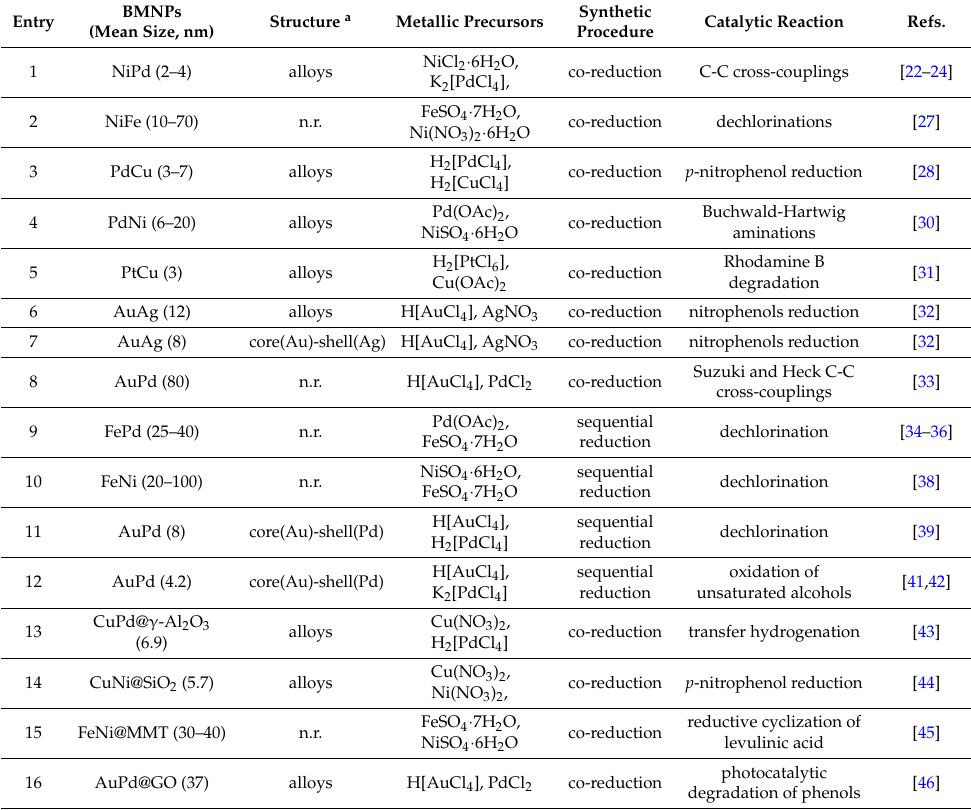
Table 1. Bimetallic nanoparticles in water applied in catalysis.